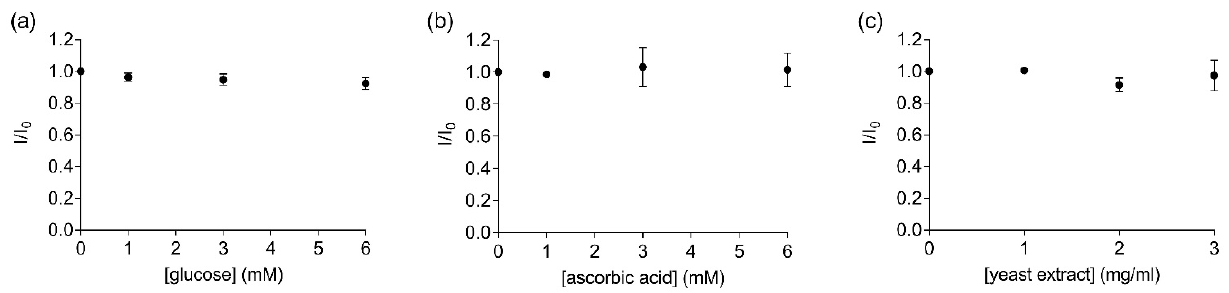
Figure 4. Ratios of the fluorescent intensity (mean ± SD, n = 3) of 67 nM labelled EST2-S35C at the maximum of emission (457–461) in the presence (I) and the absence (I 0 ) of different concentrations of the tested substances: ( a ) glucose (mM); ( b ) ascorbic acid (mM); ( c ) yeast extract (mg/mL).